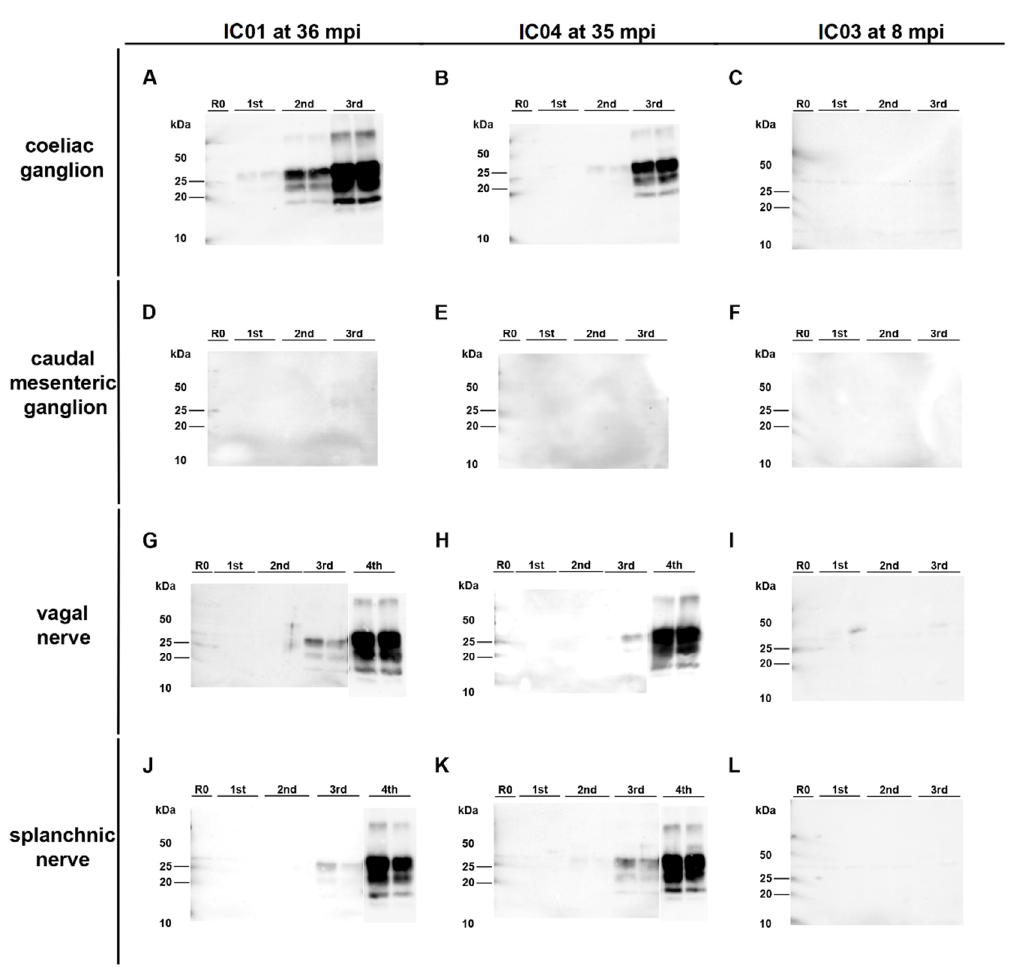
Figure 5. PrP BSE amplification by PMCA in nervous tissue samples from positive control cattle. ( A , B , D , E ): Seeding activity was present in the coeliac ganglion of the positive controls IC 01 (36 mpi; ( A )) and 04 (35 mpi; ( B )) as shown by +++ ( A ) and ++ ( B ) positive PMCA reactions, while–in contrast to IHC–no PrP BSE was detectable by PMCA in the caudal mesenteric ganglion of IC 01 ( D ) and 04 ( E ); ( G , H , J , K ): + positive PMCA reactions confirmed the presence of PrP BSE in the parasympathetic vagal nerve ( G , H ) and sympathetic splanchnic nerve ( J , K ) of IC 01 ( G , J ) and 04 ( H , K ); ( C , F , I , L ): the mentioned peripheral ganglia and nerves of IC 03 (8 mpi) were negative by PMCA; All analyte tissue samples were analyzed in duplicate and subjected to 3 rounds (1st, 2nd, 3rd) of PMCA. An additional fourth round confirmed PrP BSE amplification of weak positive results obtained with the initial PMCA run of some samples. M: marker, R0: analyte homogenate diluted 1:10 in Tgbov XV brain substrate without sonication.